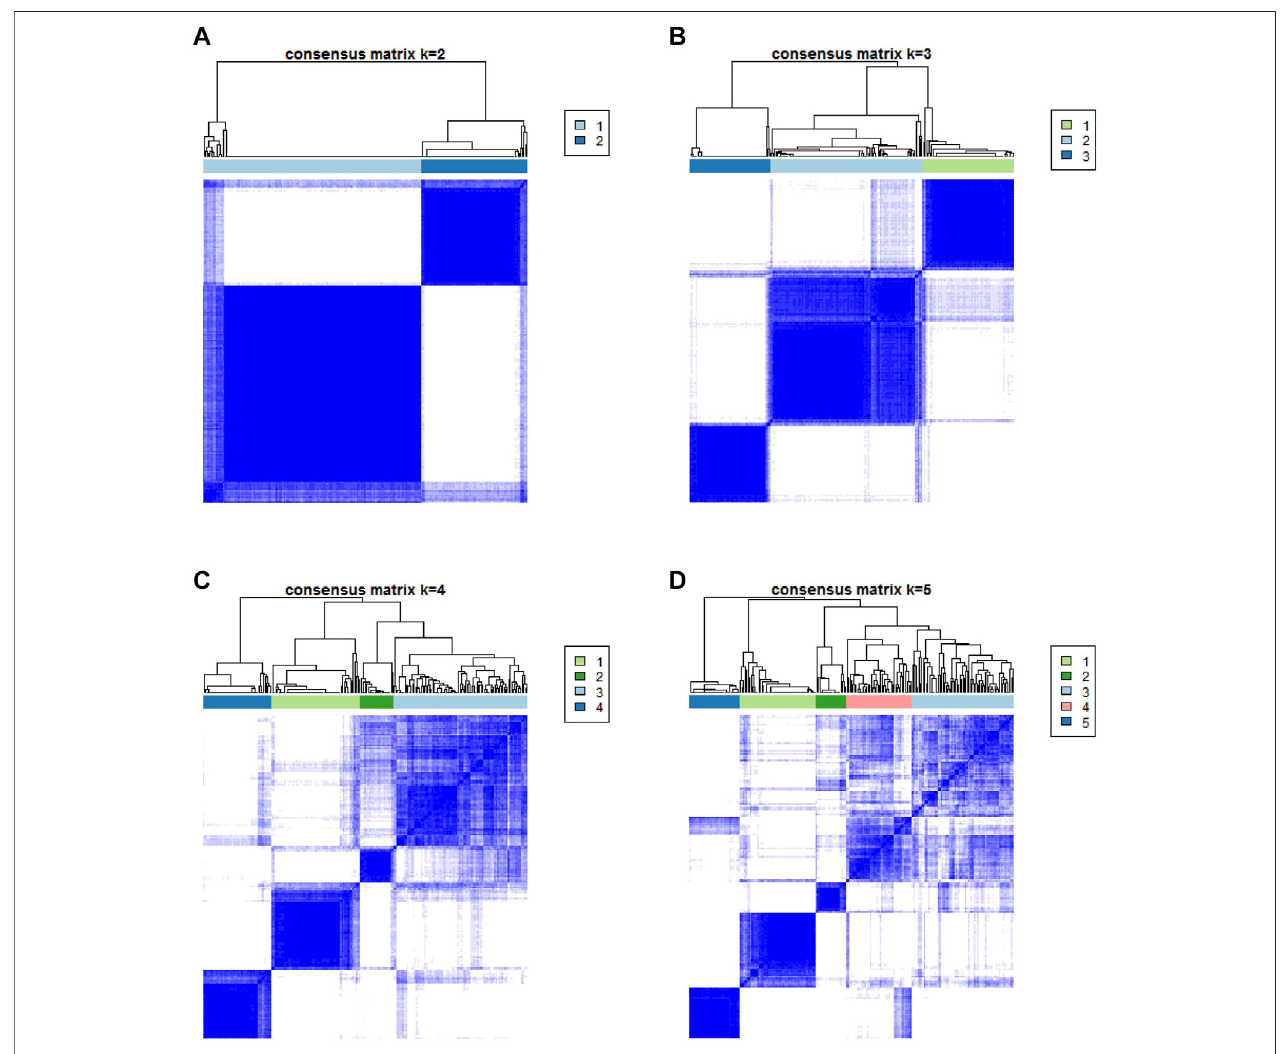
FIGURE 2 | Based on the proportion of in fi ltrating immune cells, consensus matrixes of all BLCA samples. (A – D) In consensus matrixes of all BLCA samples for each k (k = 2 – 5), the consensus matrix was the crispest when K = 2.